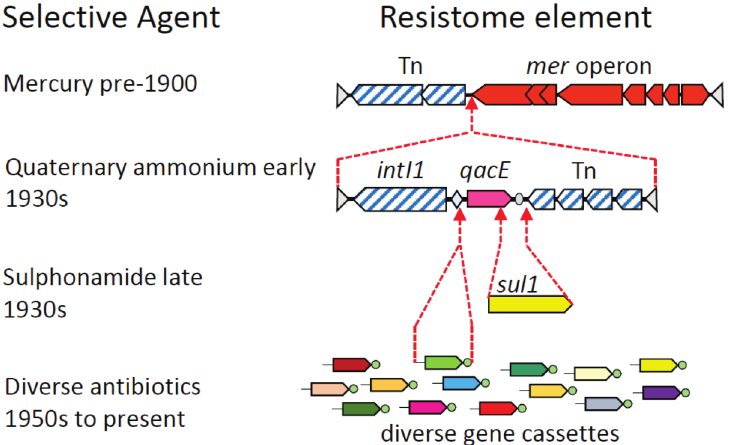
Figure 2. Schematic illustrating the sequential assembly of complex, mosaic DNA elements under the influence of human selection. The proposed history of transposon Tn 21 is used as an example [43,49,50]. Open reading frames conferring resistance phenotypes are represented by solid color; genes for DNA recombination, such as the integron-integrase intI1 and transposition machinery, have diagonal hatching. The sequential series of selection events that is thought to have fixed each additional resistance gene to form larger and more complex elements are shown. These resistance determinants include: a mer operon (mercury resistance); qacE (resistance to quaternary ammonium compounds); sul1 (resistance to sulphonamides); and integron gene cassettes (resistance to diverse antibiotics). Only one of the many acquisitions of different integron gene cassettes is shown. For details of integron diversity and activity see